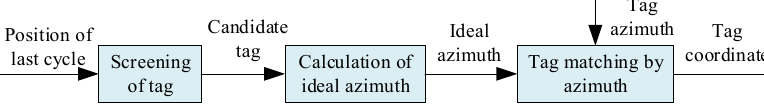
Figure 4. Matching process for observed and stored tags.